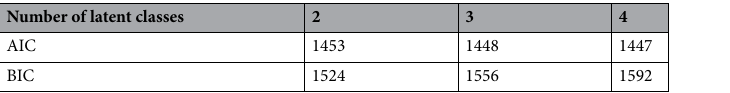
Table 1. Model selection criteria for latent class analysis. AIC Akaike information criterion, BIC Bayesian information criterion.